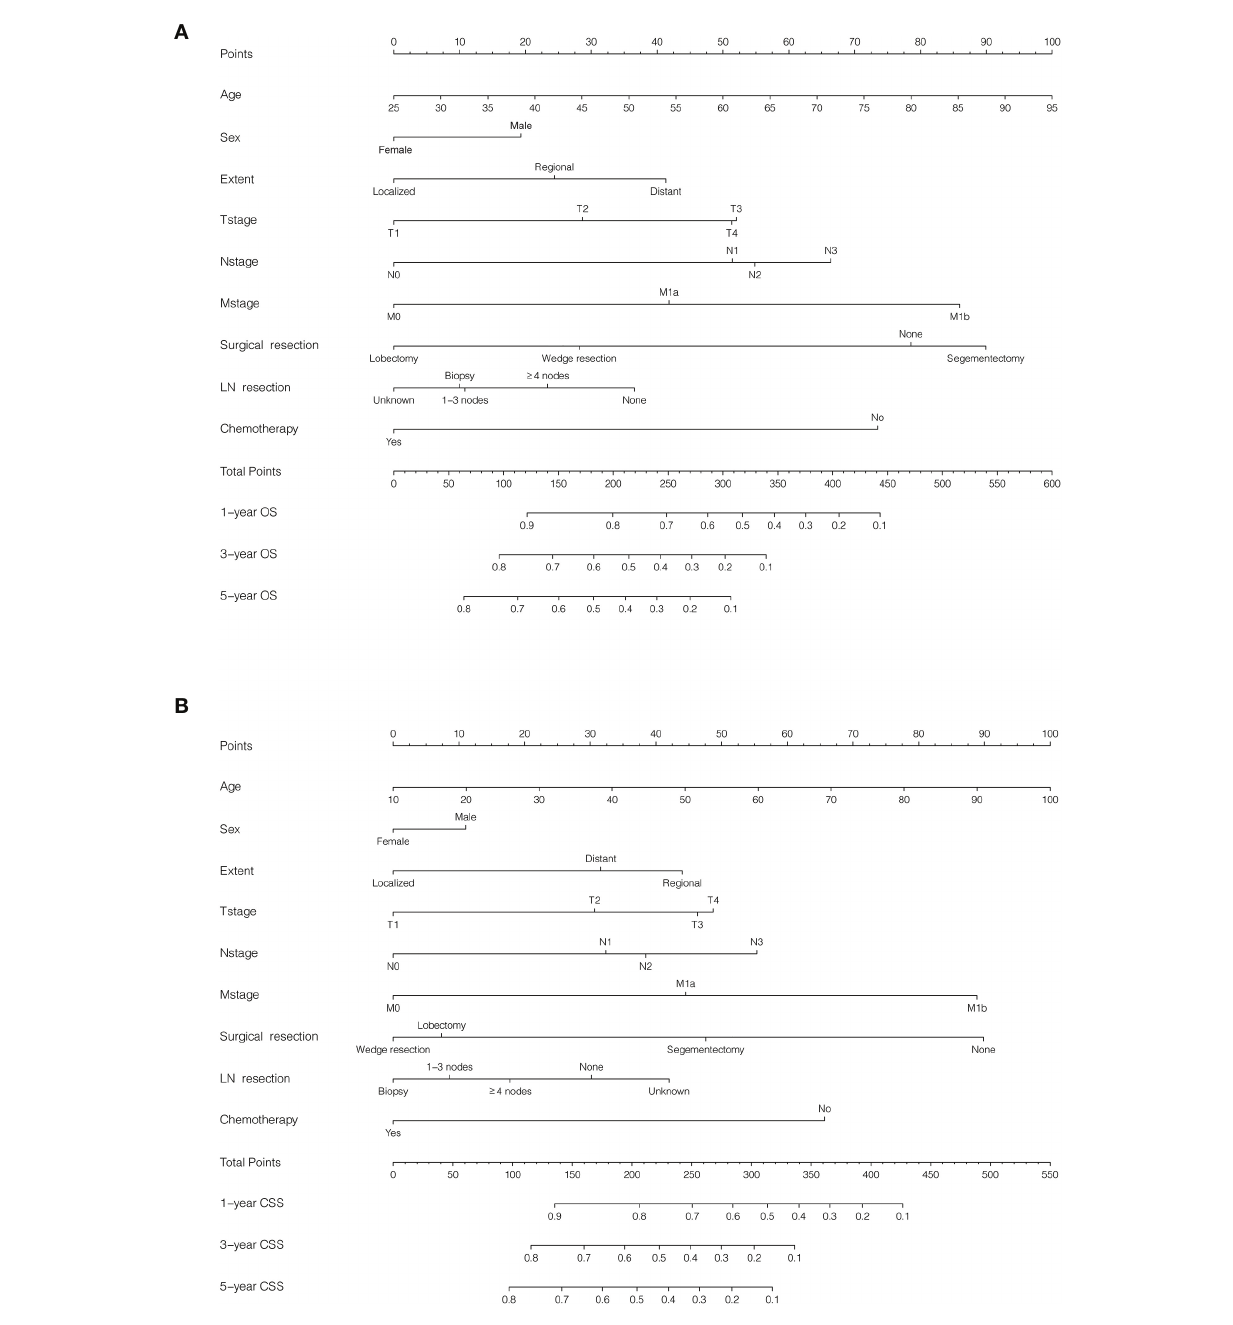
FIGURE 4 | Nomogram for predicting survival in patients with pulmonary large cell neuroendocrine carcinoma using SEER 18 Regs Custom Data (with additional treatment fi elds; November 2018 Submitted). Patients were randomly split into training and validation cohorts by a ratio of 7:3. (A) Overall survival (OS), C-index: 0.775 (95%CI: 0.746-0.804) in the training cohort and 0.729 (95%CI: 0.6760.782) in the validation cohort; (B) Cancer-speci fi c survival (CSS), C-index: 0.783 (95%CI: 0.736-0.802) in the training cohort and 0.783 (95%CI: 0.734-0.832) in the validation